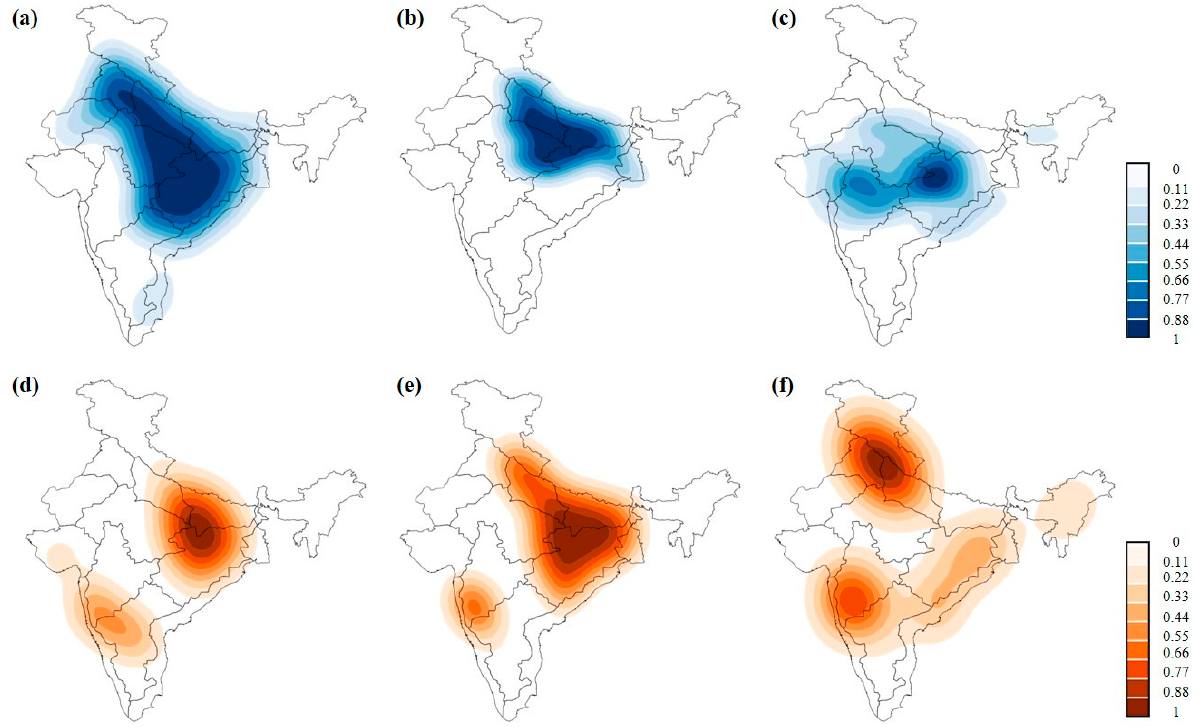
Figure 9. Regions showing statistically significant composite anomalies of air temperature ( ◦ C) across India during the month of June when SST anomalies of the Western Indian Ocean ( a , d ), Northern Indian Ocean ( b , e ) and Central Indian Ocean ( c , f ) demonstrated positive (upper) and negative (lower) variations. The colour bar shows the scaled density estimate of positive (blue) and negative (orange) air temperature anomalies. The warmer SST in the oceanic regions leads to positive air temperature anomalies, while the colder SST leads to negative air temperature anomalies in the shaded areas.